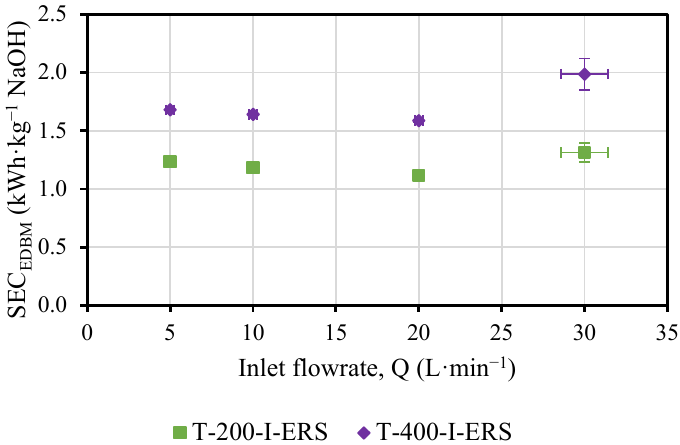
Both the SEC EDBM (Figure 7) and the CE EDBM (Figure 8) were slightly affected by the variations in concentration obtained.